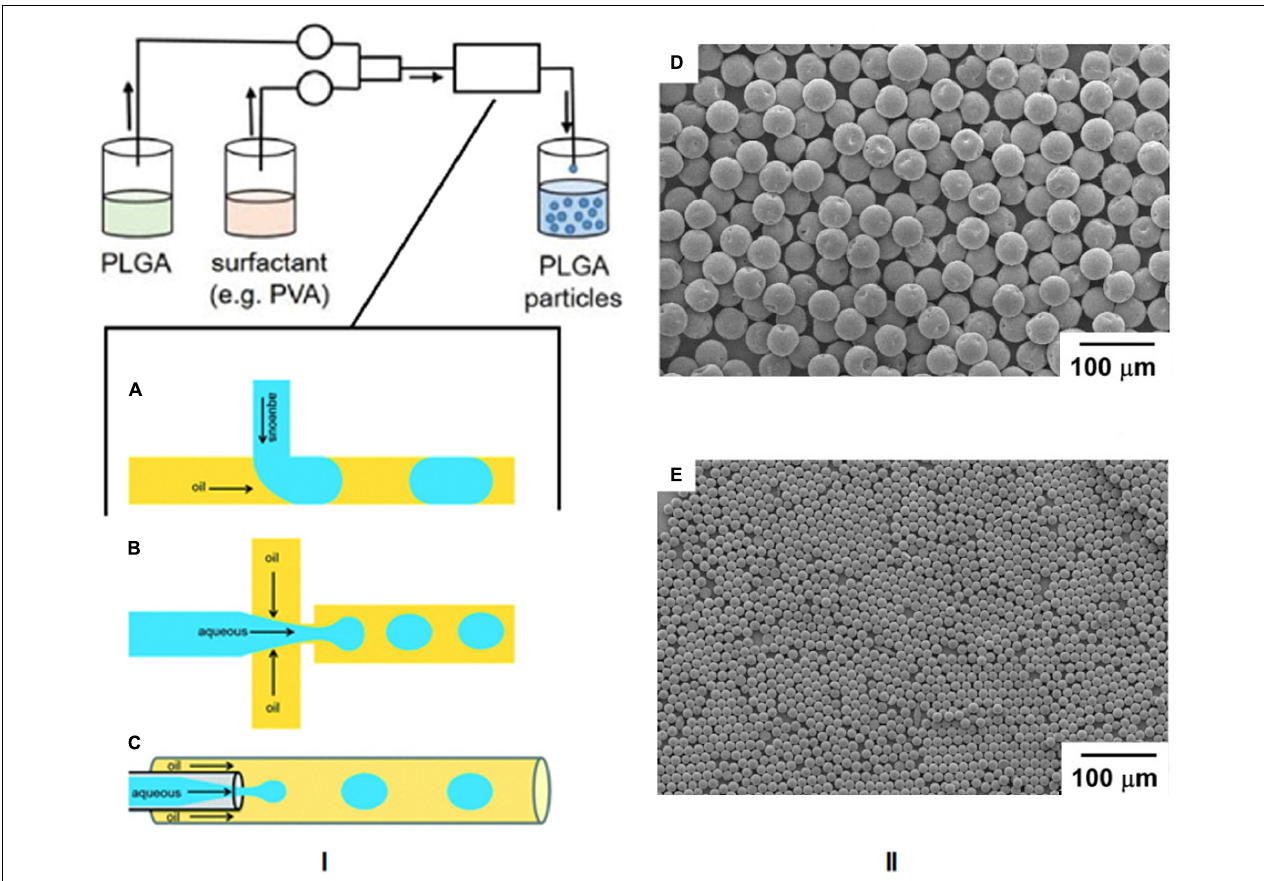
FIGURE 8 | (I) Schematic of the microfluidics method and the three most common microchannel geometries. (A) T junction, (B) flow focusing, (C) continuous flow. Reproduced from Shembekar et al. (2016)-published by the Royal Society of Chemistry. (II-D,E) SEM images of PLGA particles formed by this technique, adapted from Xu et al.